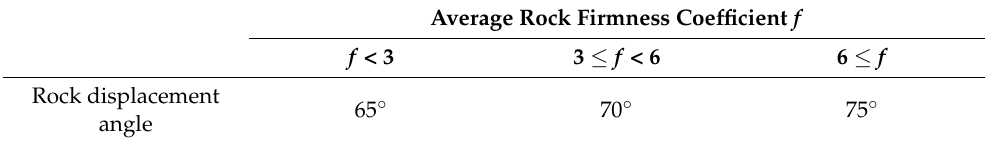
Table 3. Displacement angle ( β r ) of strata.